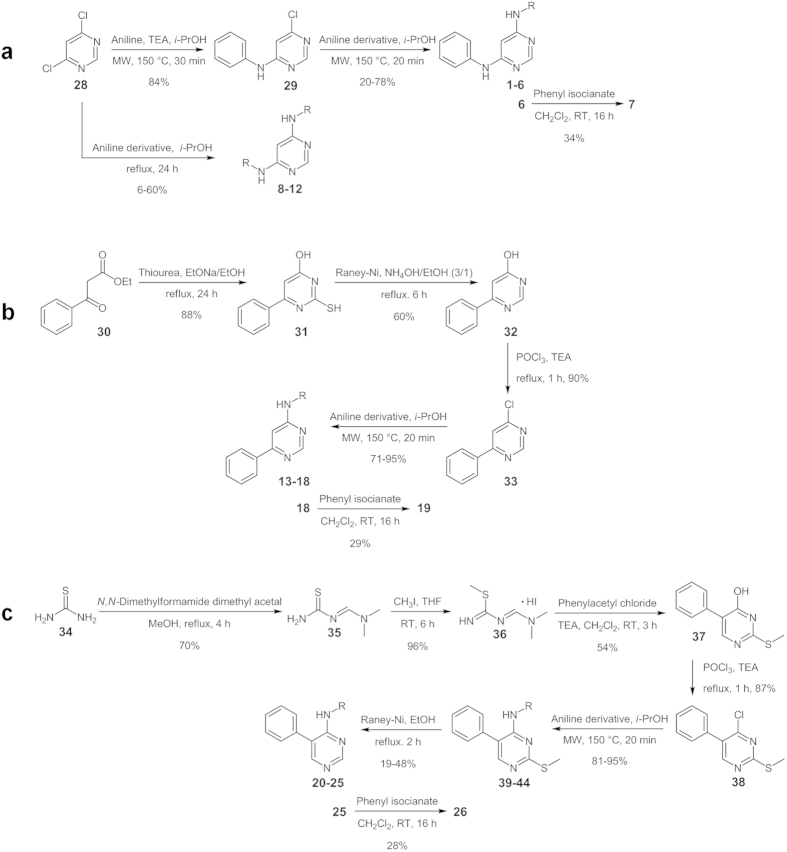
Synthesis of compounds 1–26.See Fig. 2 for R specification.